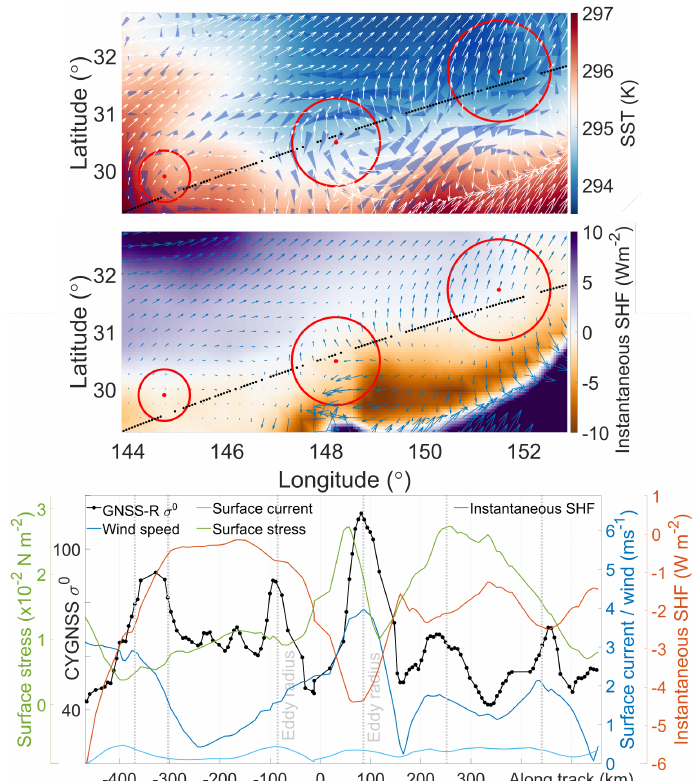
Figure 4. A track of Cyclone GNSS (CYGNSS) overpassing three eddies on 4 June 2017, 08:11. The top panel displays sea surface temperature, surface wind (white arrows) and current (blue cones). In the middle, instantaneous surface sensible heat flux (SHF) as well as surface stress (blue arrows) are visualized. The bottom panel profiles CYGNSS σ 0 along with the wind and current velocity, instantaneous SHF and surface stress magnitudes, referenced at the center of the middle